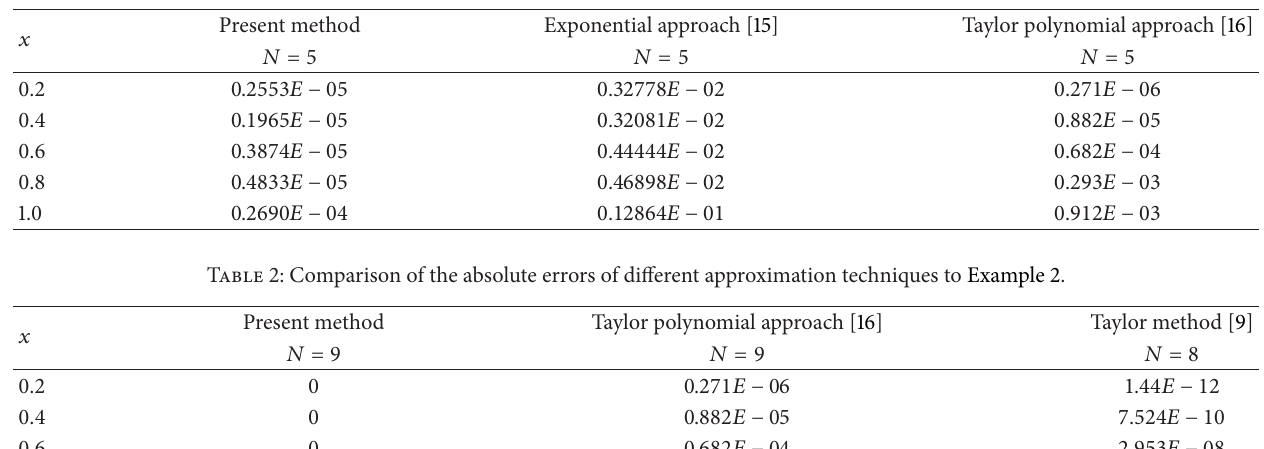
Table 1: Comparison of the absolute errors of different approximation techniques to Example 2.